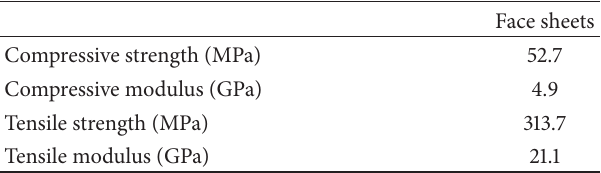
Table 2: Material properties of GFRP face